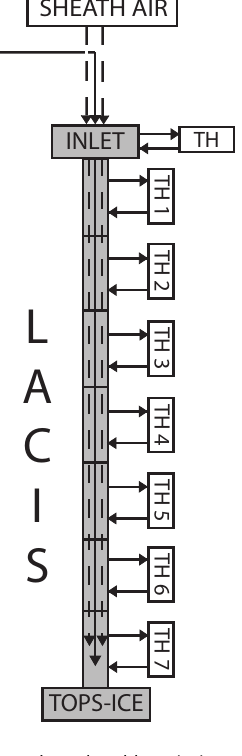
Fig. 1. Setup of the LACIS flow tube. The abbreviation TOPS-ICE stands for Thermally Stabilized Optical Particle Spectrometer.